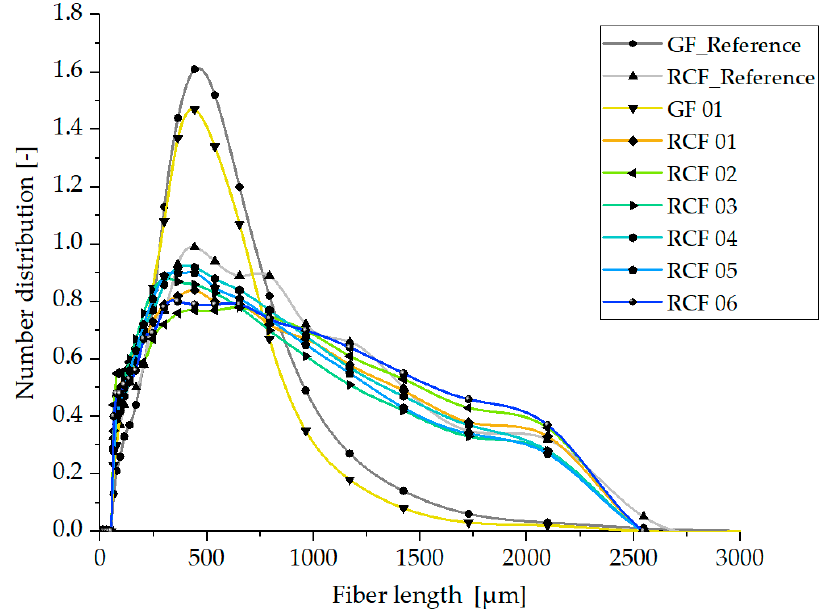
Figure 8. Fiber length distribution in specimen produced with the valve gate hot runner system.